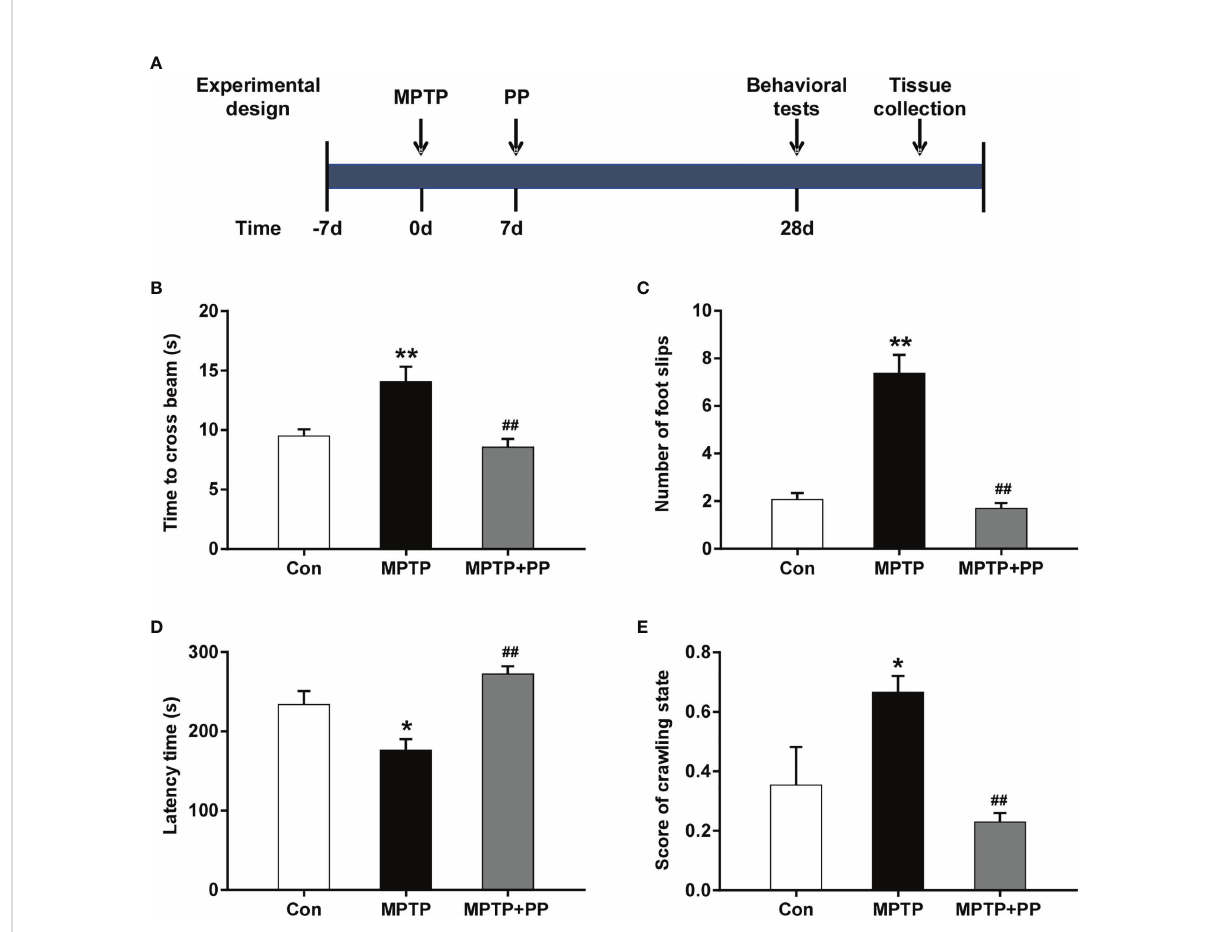
FIGURE 1 Pediococcus pentosaceus treatment inhibited the methyl-4-phenyl-1,2,3,6-tetrahydropyridine (MPTP)-induced motor dysfunction. (A) Schematic diagram of the animal experiments. (B) Time to cross the beam in the balance beam test. (C) Number of foot slips in the balance beam test. (D) Latency time in the rotarod test. (E) Score of crawling state in the pole test. Statistical comparison by one-way ANOVA with